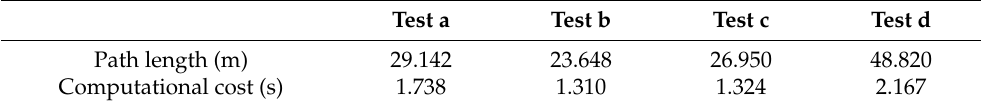
Figure 10. Trajectory of the underactuated ship: ( a ) round obstacle with collision risk; ( b ) round obstacle without collision risk; ( c ) rectangular obstacle with collision risk; and ( d ) rectangular obstacle without collision risk. Table 1. The computational cost and path length in the simulations with a single